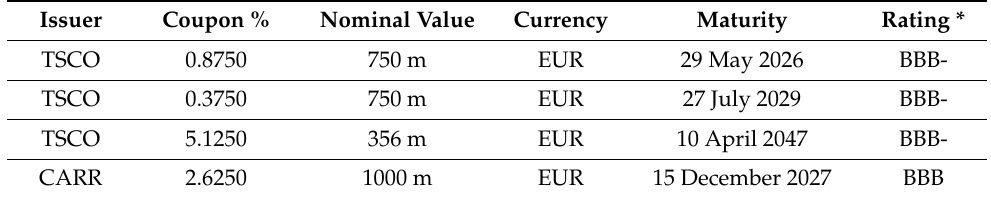
Table 1. Bonds’ characteristics.